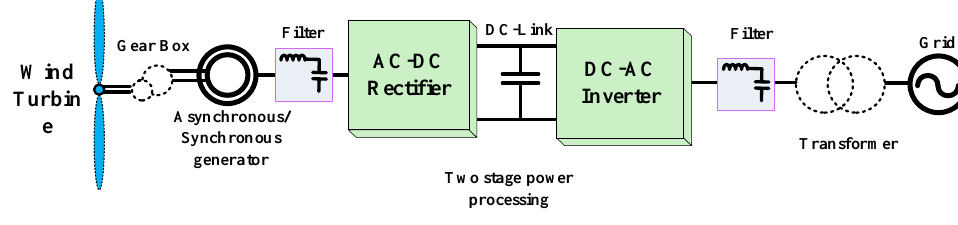
Figure 2. Structure of small wind energy power